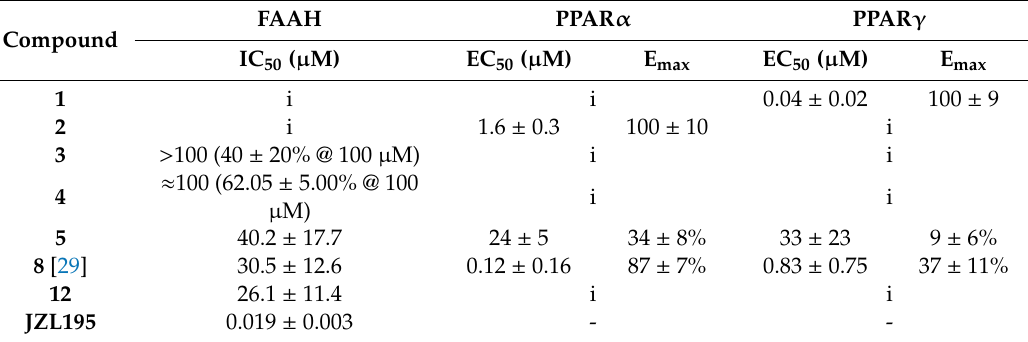
Table 1. Biological activities of PPAR standards 1 – 3 and the four most promising compounds from the initial set. i: inactive.